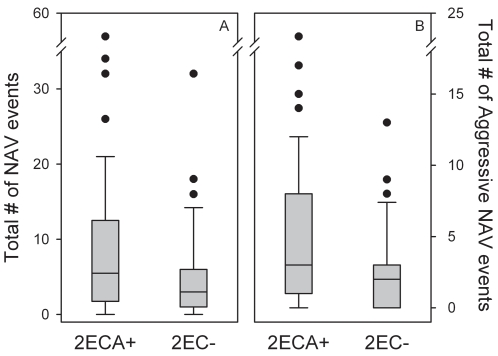
Number of NAV events (A: total, B: aggressive) performed by adults derived from two-egg clutches.Siblicidal individuals (2ECA+) are contrasted with non-siblicidal individuals (2EC-) whose sibling egg failed to hatch. Boxes and whiskers represent the middle 50% and middle 80% of the data, respectively.